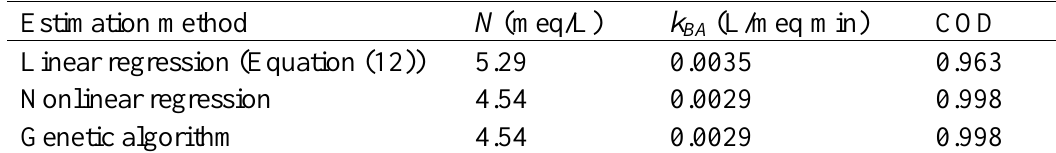
/ C calculated from t i